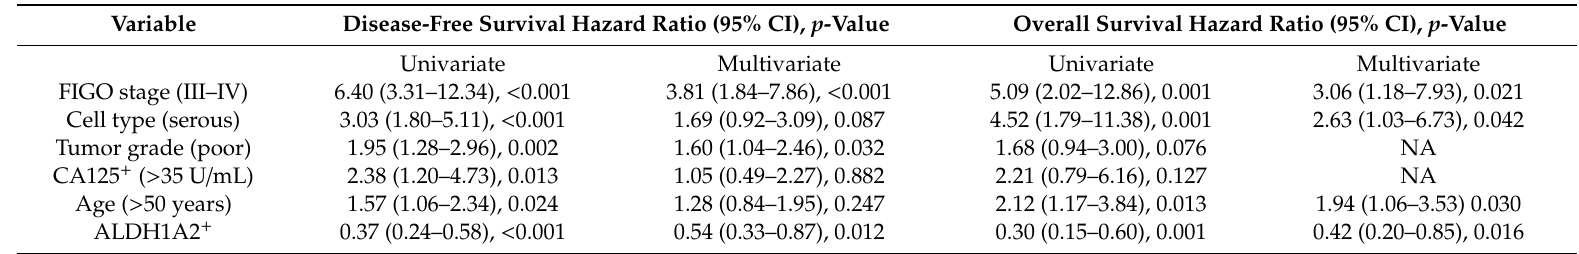
FIGO, International Federation of Gynecology and Obstetrics; CA125, cancer antigen 125; CI, confidence interval; NA, not